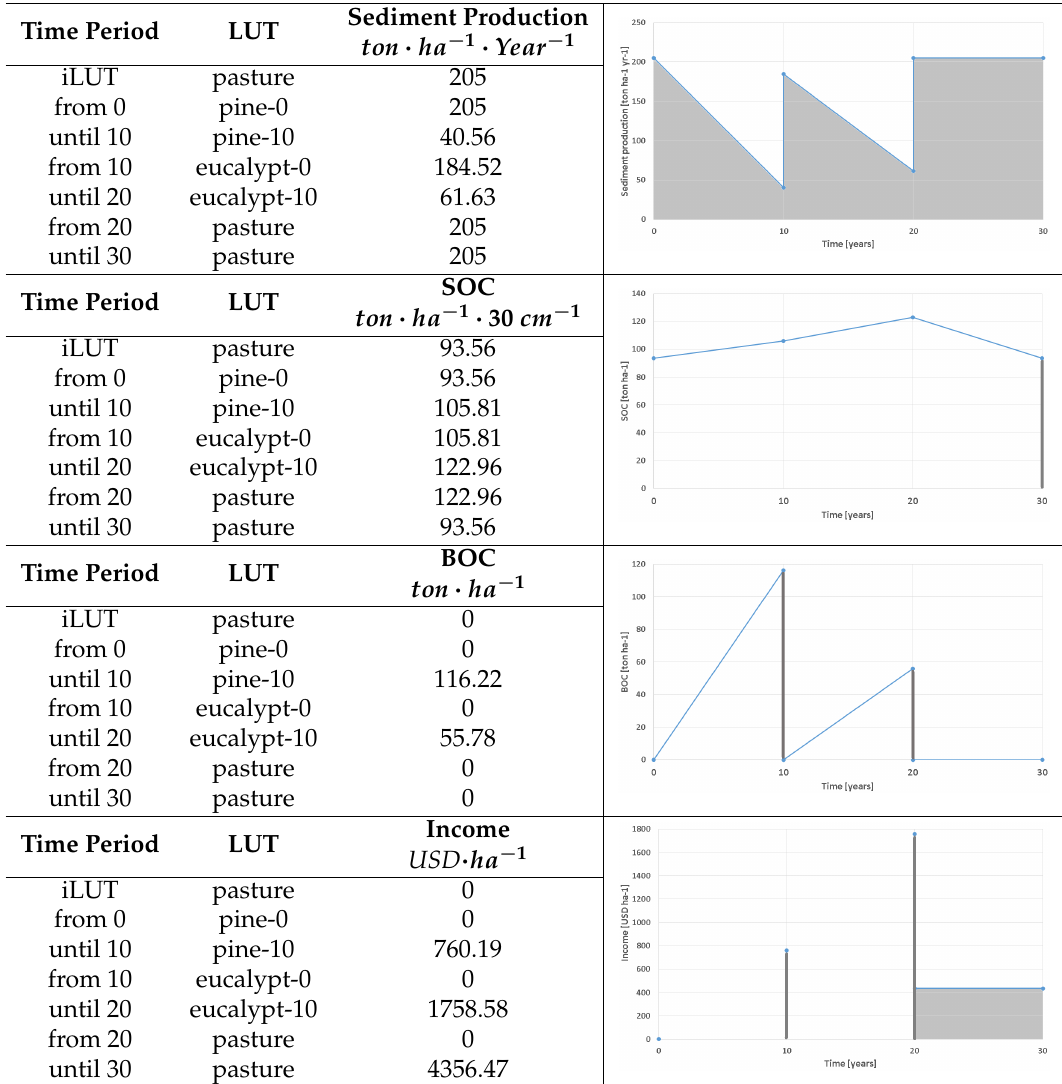
Table 4. Sediment, SOC, BOC and income performance values and graphs for sample land unit and land use